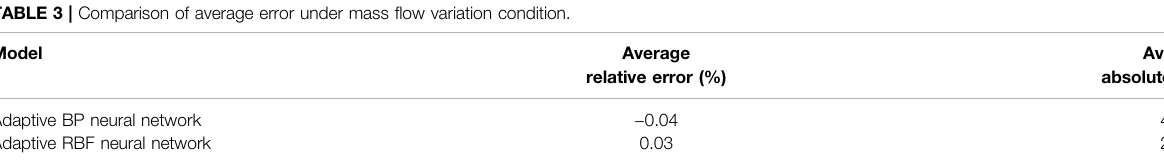
TABLE 3 | Comparison of average error under mass fl ow variation condition.